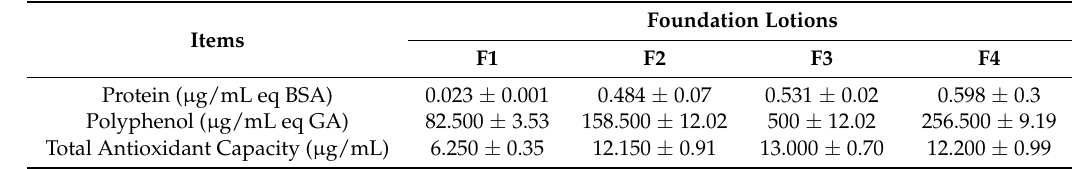
Table 1. Quantitative analysis of bioactive components and total antioxidant capacity of ethanol extract of four facial foundation lotions. Results are represented as mean ± standard deviation of three independent experiments.